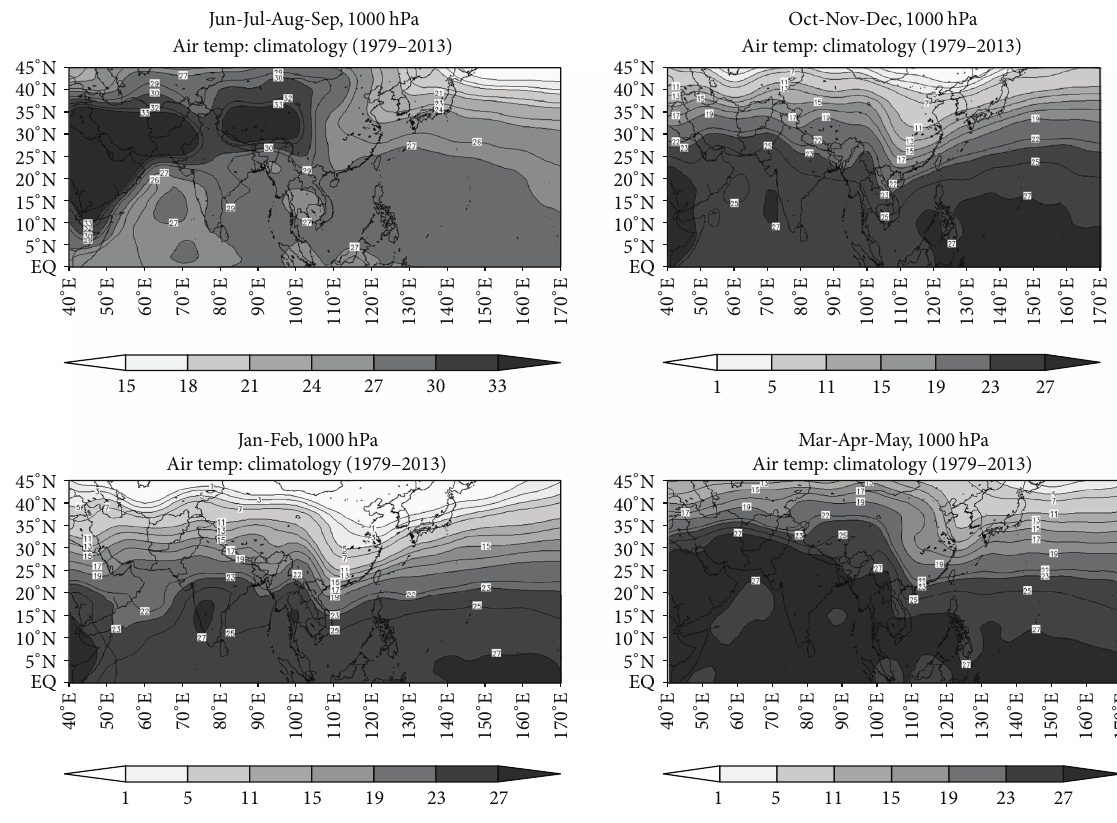
Figure 2: Seasonal climatology of monthly temperature at